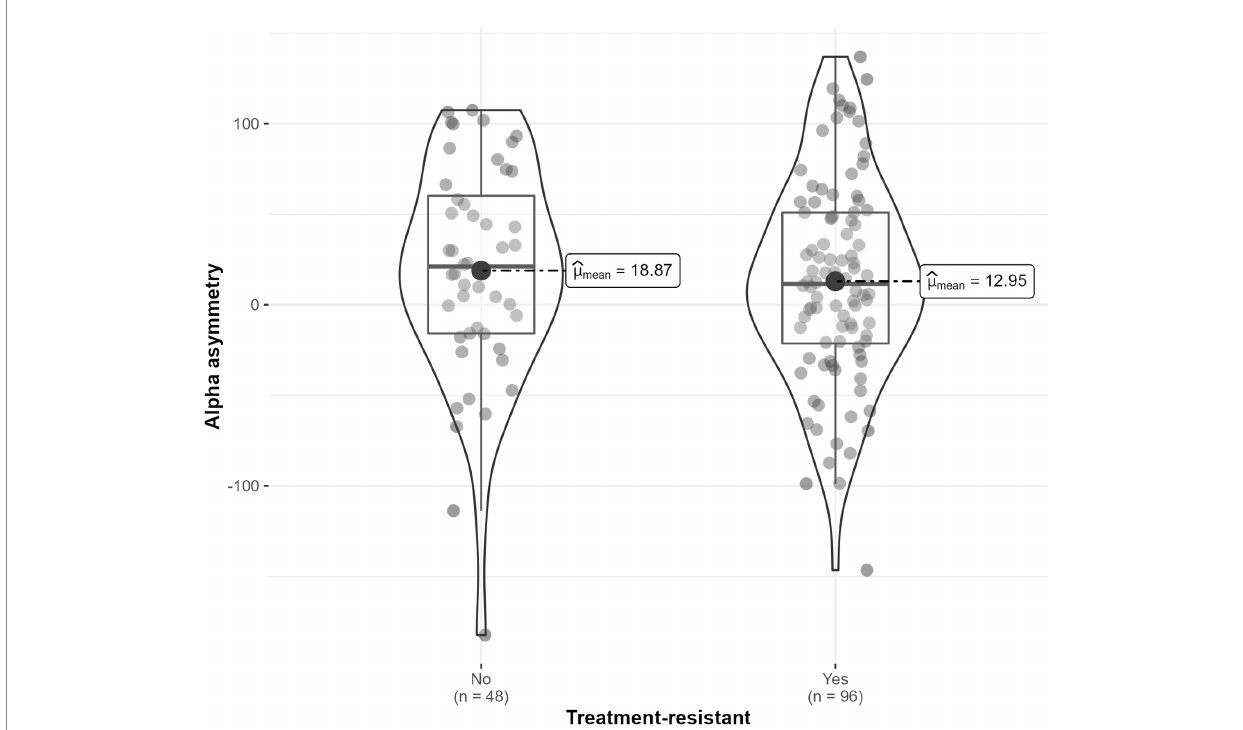
FIGURE 8 Alpha asymmetry scores distribution for participant with and without treatment-resistant depressive disorder.